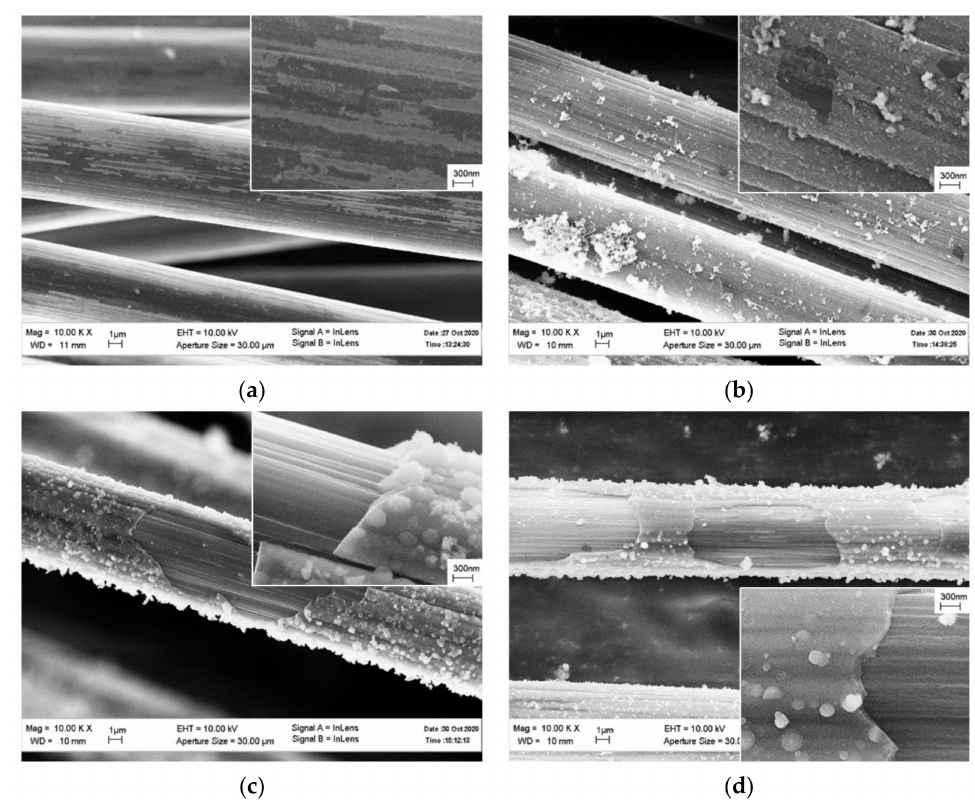
Figure 3. Surface of the coated carbon fiber formed in the reaction medium with KNO 3 salt concentration from 0 to 30 g/L: